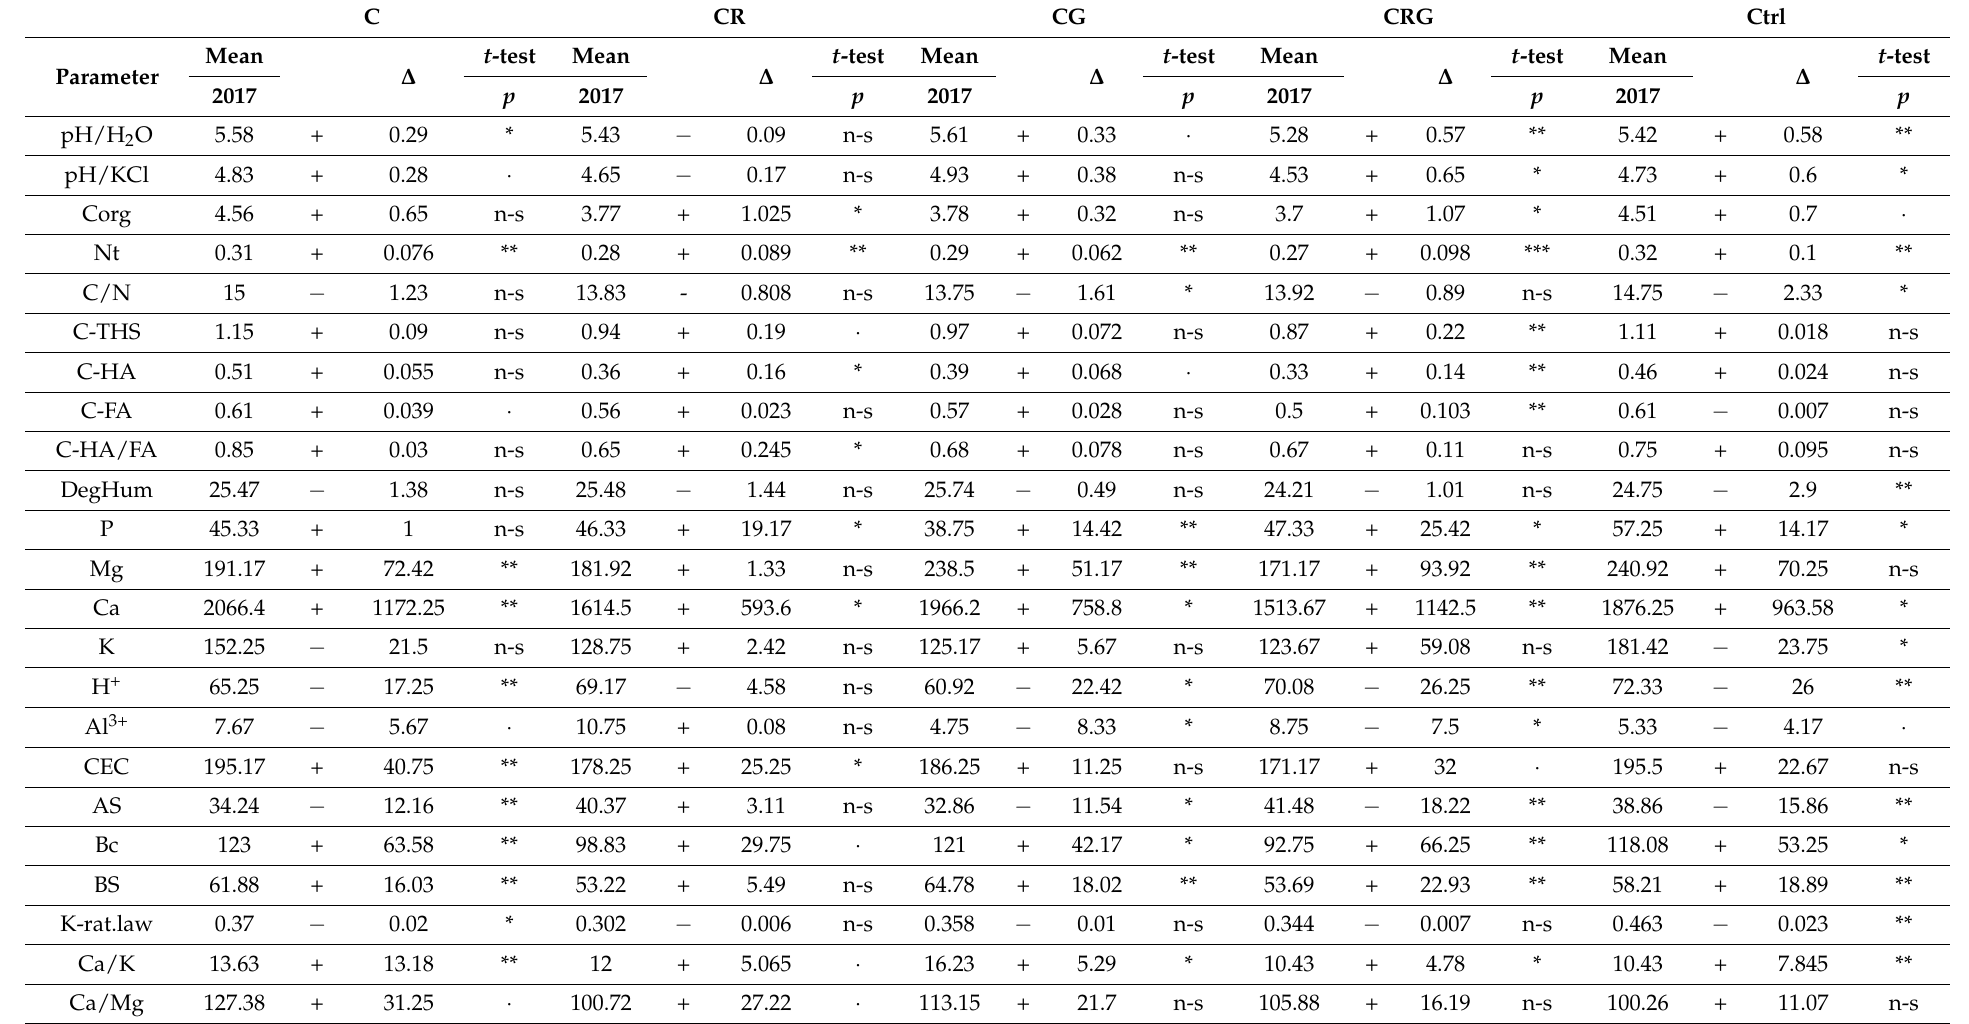
Table 1. The results of the paired t -test comparison of the soil parameter values in relation to the individual treatments in 2018 and 2017. n-s > α ; 0.05–0.1; * 0.01–0.05; ** 0.001–0.01; *** < 0.001. C CR CG CRG Ctrl t -test Mean t -test Mean t -test Mean t -test Mean t -test Mean ∆ ∆ ∆ ∆ ∆ Parameter 2017 p 2017 p 2017 p 2017 p 2017 p pH/H 2 O 5.58 + 0.29 * 5.43 − 0.09 n-s 5.61 + 0.33 · 5.28 0.57 0.58 ** pH/KCl 4.83 + 0.28 · 4.65 0.17 4.73 0.6 * Corg 4.56 + 0.65 n-s 3.77 1.025 3.78 0.32 n-s 3.7 1.07 4.51 + 0.7 · Nt 0.31 + 0.076 ** 0.28 + 0.089 ** 0.29 + 0.062 ** 0.27 + 0.098 *** 0.32 + 0.1 ** C/N 15 − 1.23 n-s 13.83 - 0.808 n-s 13.75 − 1.61 * 13.92 − 0.89 n-s 14.75 − 2.33 * C-THS 1.15 + 0.09 n-s 0.94 + 0.19 · 0.97 + 0.072 n-s 0.87 + 0.22 ** 1.11 + 0.018 n-s C-HA 0.51 + 0.055 n-s 0.36 + 0.16 * 0.39 + 0.068 · 0.33 + 0.14 ** 0.46 + 0.024 n-s C-FA 0.61 + 0.039 ·